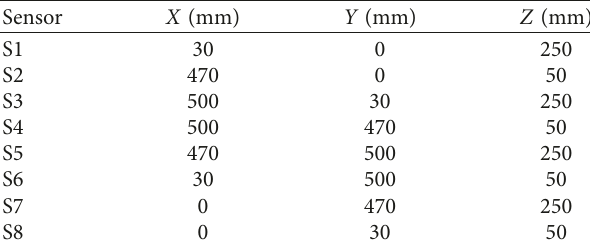
Figure 4: Schematic diagram of the experimental system. I (acoustic emission acquisition unit): (1) desktop computer (signal display) and (2) AE system (8 channels); II (acoustic emission preamplifiers unit): (3) AE preamplifiers (20/40/60dB); III (monitoring unit of concrete structures and AE sensors): (4) AE sensors (frequency range: 50–400kHz, center frequency: 150kHz) and (5) concrete blocks; IV (mi- crometer unit): (6) micrometers, (7) fixed support, and (8) data acquisition instrument. Table 3: The spatial coordinates of the points at which the sensors were attached to the test